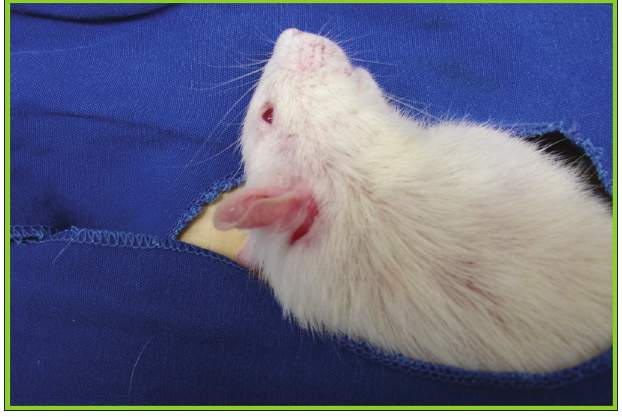
Figure 1. Behind-the-ear incision in a rat used in the experiment.